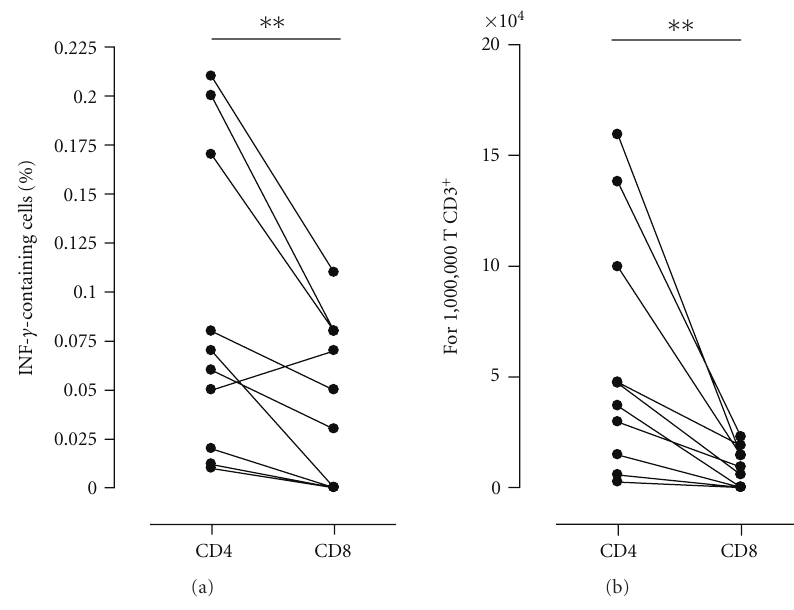
Figure 2: Percentages and absolute numbers of FHA-induced IFN- γ producing CD4 + and CD8 + T cells in B. pertussis -infected ( n = 6) or vaccinated children ( n = 4). Isolated PBMC were stimulated in vitro for 24 h with 5 μ g/mL FHA, and IFN- γ -containing CD4 + (left columns) and CD8 + (right columns) T lymphocytes were detected by flow cytometry. (a) represents the percentages of positive cells and the absolute numbers of IFN- γ -producing cells expressed for 10 6 CD3 + T lymphocytes are shown on (b). The lines join the results obtained for the same children. Percentages obtained for unstimulated cells were subtracted from those obtained for stimulated cells. ∗ P < 0 . 05, ∗∗ P < 0 .